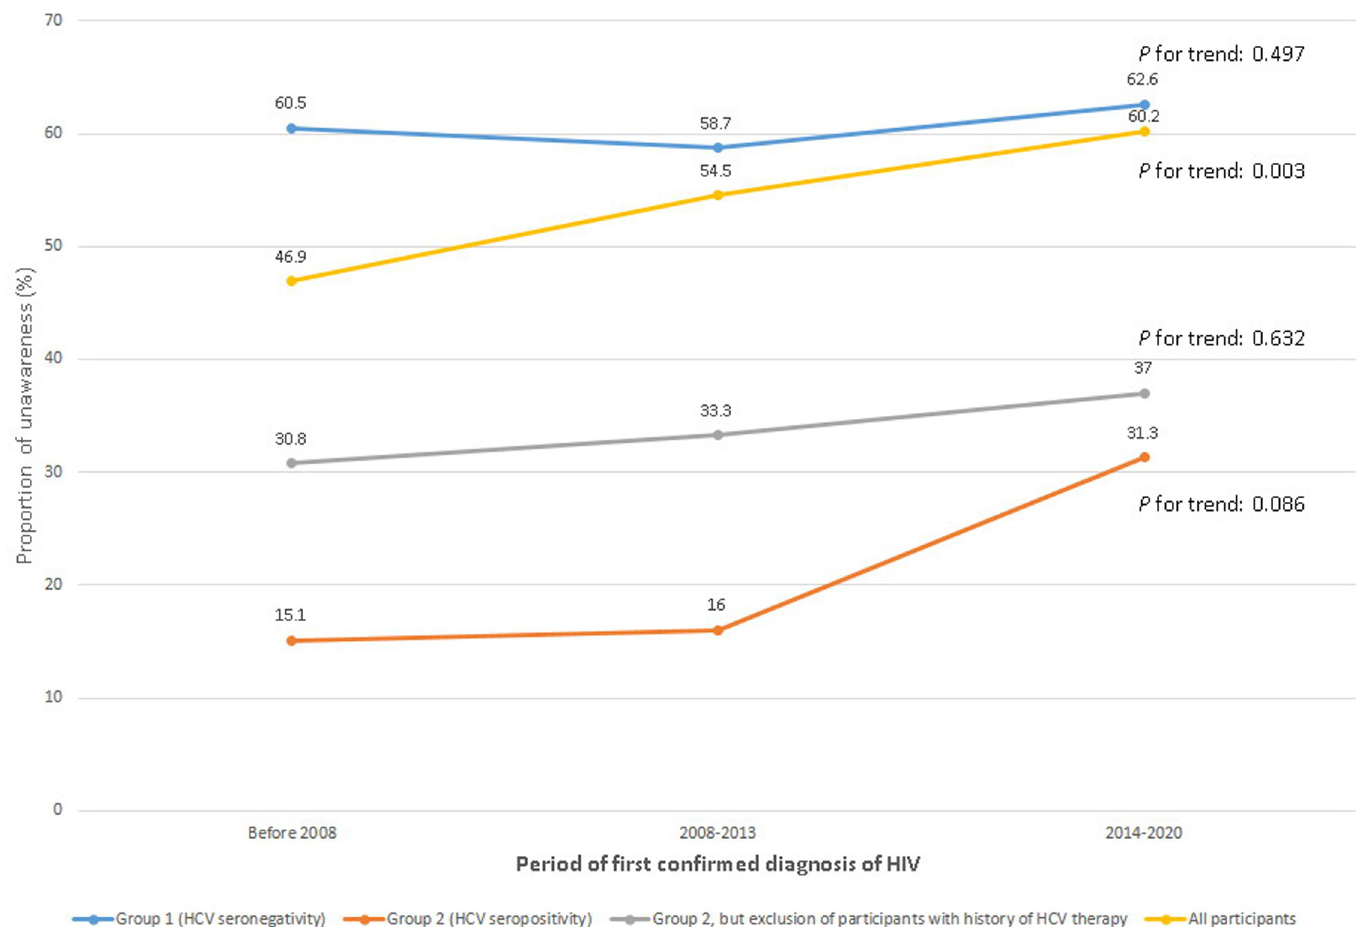
Fig 2. Trend analyses of prevalence of UoHCV stratified by HCV serostatus in three periods according to the calendar year of first confirmed HIV diagnosis (period 1 [before 2008], period 2 [2008–2013], and period 3 [2014–2020]). Prevalence of unawareness of HCV infection status across the three periods among all participants and among HCV-seronegative individuals, HCV-seropositive individuals receiving HCV therapy, and HCV-seropositive individuals not receiving HCV therapy. Cochran–Armitage trend test with modified ridit scores was used to analyze the trends in the prevalence of unawareness of HCV infection status for periods 1 to 3. Abbreviations: HCV, hepatitis C